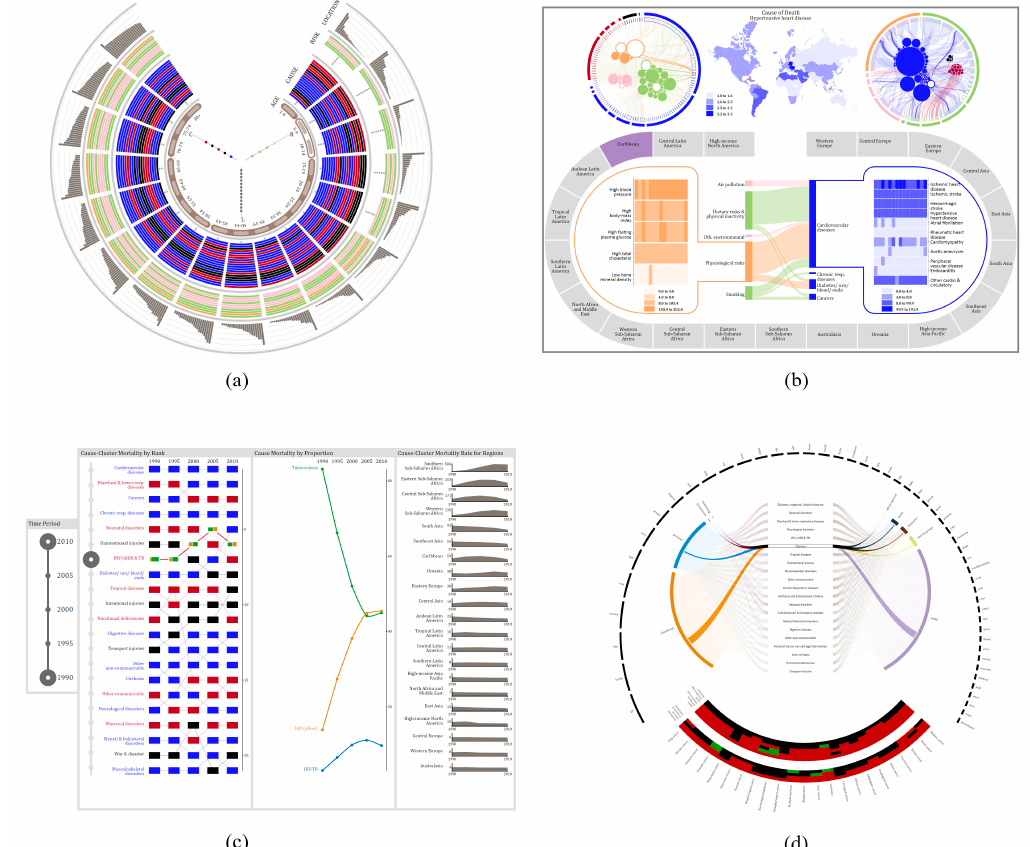
Figure 2. ( a ) Demography visualization; ( b ) Geography visualization; ( c ) Chronology visualization; and, ( d ) Sentiment visualization.